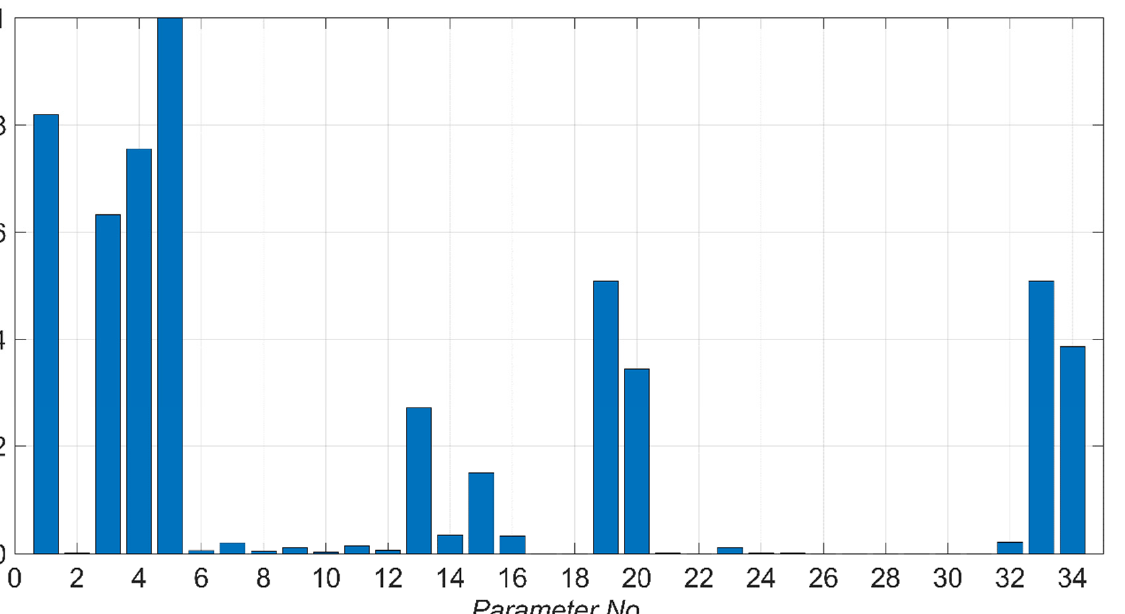
( b ) Figure 8. Relative mutual entropy gain between model parameter pairs: ( a ) without scaling, ( b ) with scaling. 3.3. Verification Study Using Numerically Simulated Data To simulate the measurements, the FE response of the SRC bridge to the 2004 Isla Vista earthquake is simulated and polluted with an artificial zero-mean Gaussian noise with 5% Root Mean Square (RMS) noise-to-signal ratio. For the simulation, the measured free field motions are used as the FIMs. The time history analysis is performed using time step size of 0.01 sec and the Newmark-beta average acceleration method for time integra- tion, with the nominal model parameter values presented in Table 2. The noisy simulated responses are used for model updating to estimate the six unknown model parameters and the FIM time histories in the longitudinal and transverse directions. It should be noted that due to the short length of the SRC bridge, the FIMs are assumed to be uniform. As